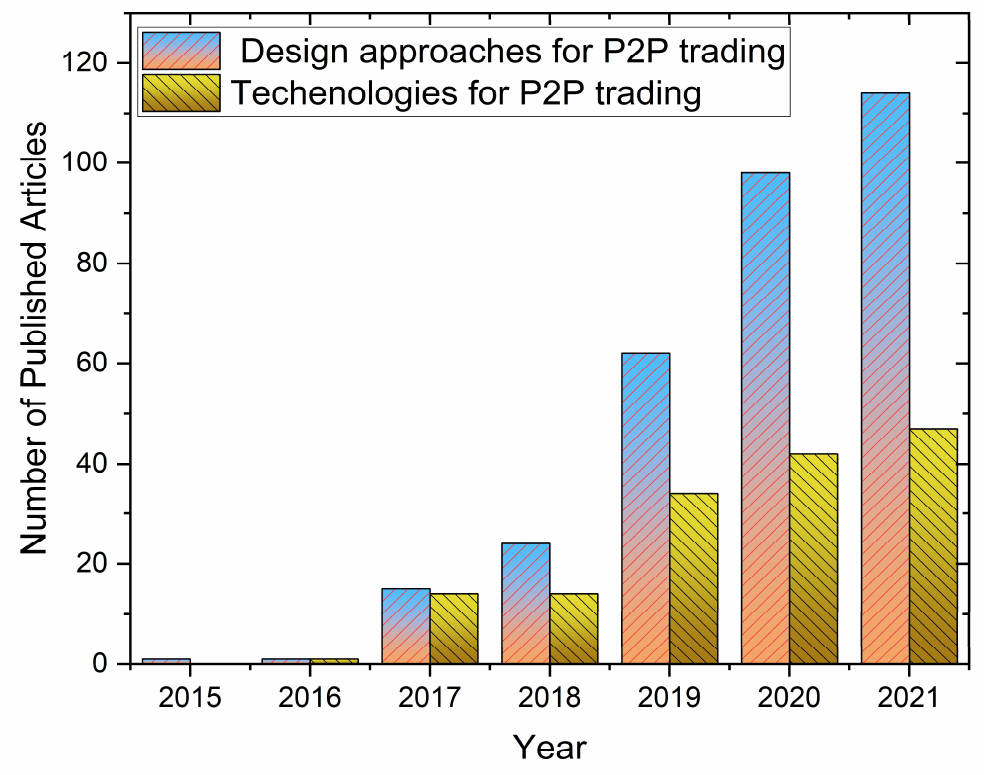
Figure 1. Number of published papers on peer-to-peer (P2P) energy trading based on the Web of Science.